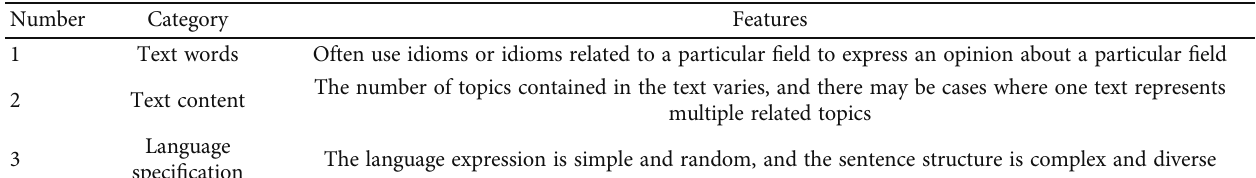
Table 2: Features of unstructured student evaluation